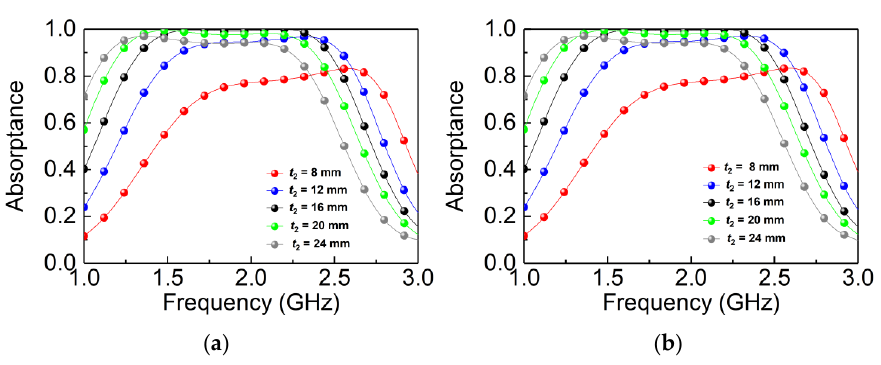
Figure 7. Simulated absorptdance with different values of t 2 : ( a ) TE wave; ( b ) TM wave.